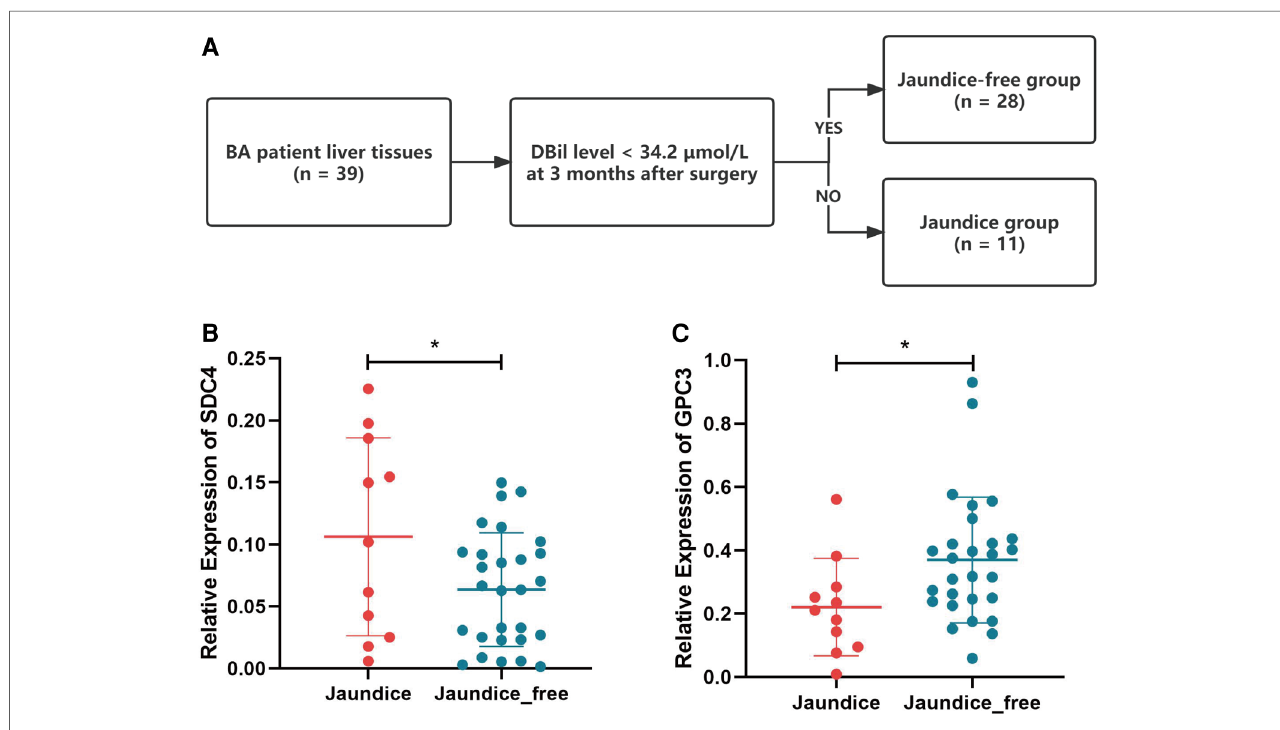
FIGURE 6 Hub HSPGs expression levels in patients with different jaundice clearance standards. ( A ) Patients were divided into 2 groups based on jaundice clearance standards. ( B ) GPC3 expression levels in 2 groups. ( C ) SDC4 expression levels in 2 groups. HSPG, heparan sulfate proteoglycan.